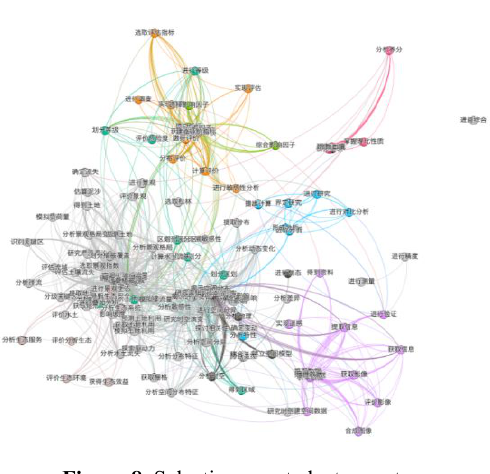
Figure 8 . Selecting event cluster centers.